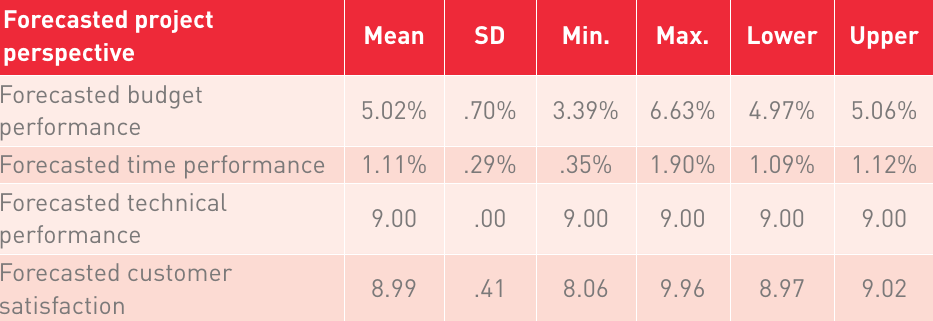
A summary of the forecasted project performance at the four perspectives, with a 95% confidence interval for